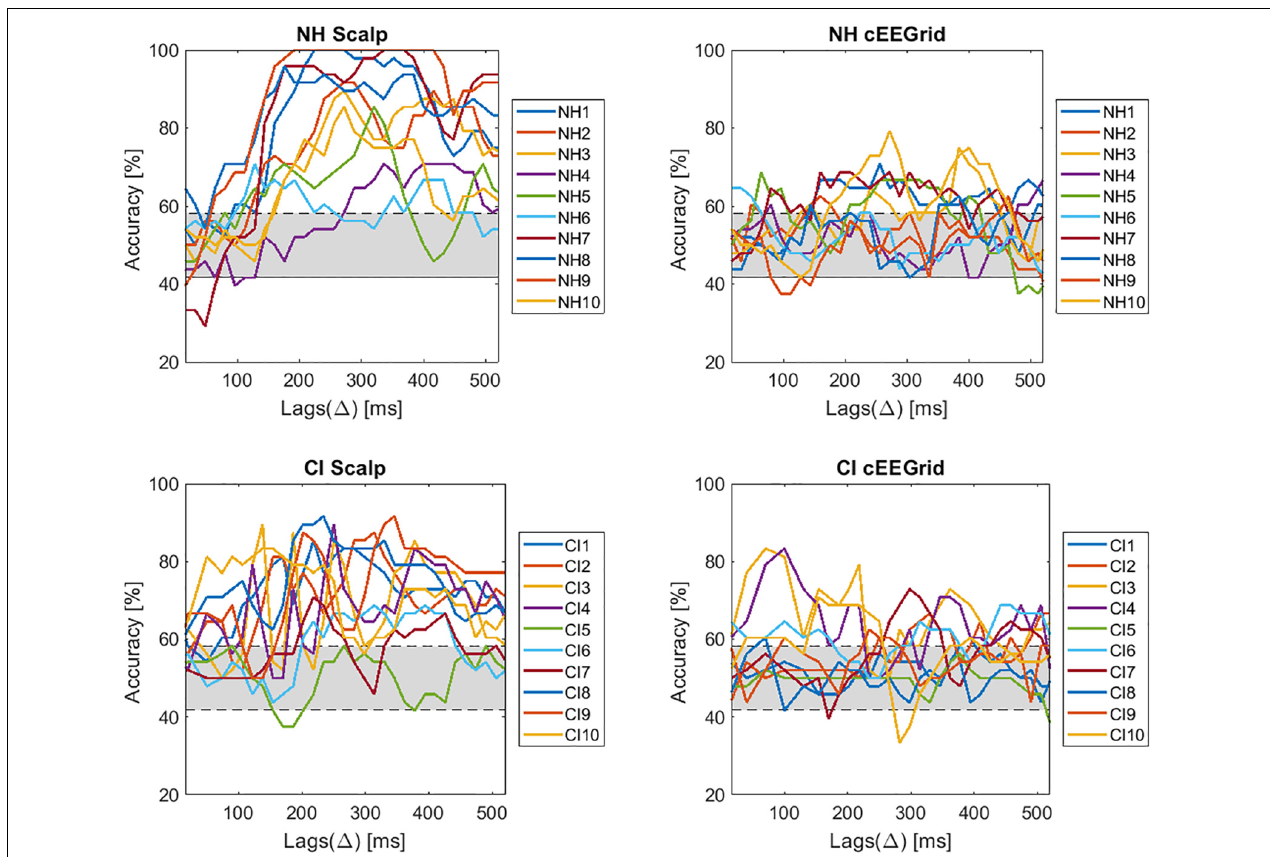
FIGURE 9 | Selective attention accuracies for each subject across